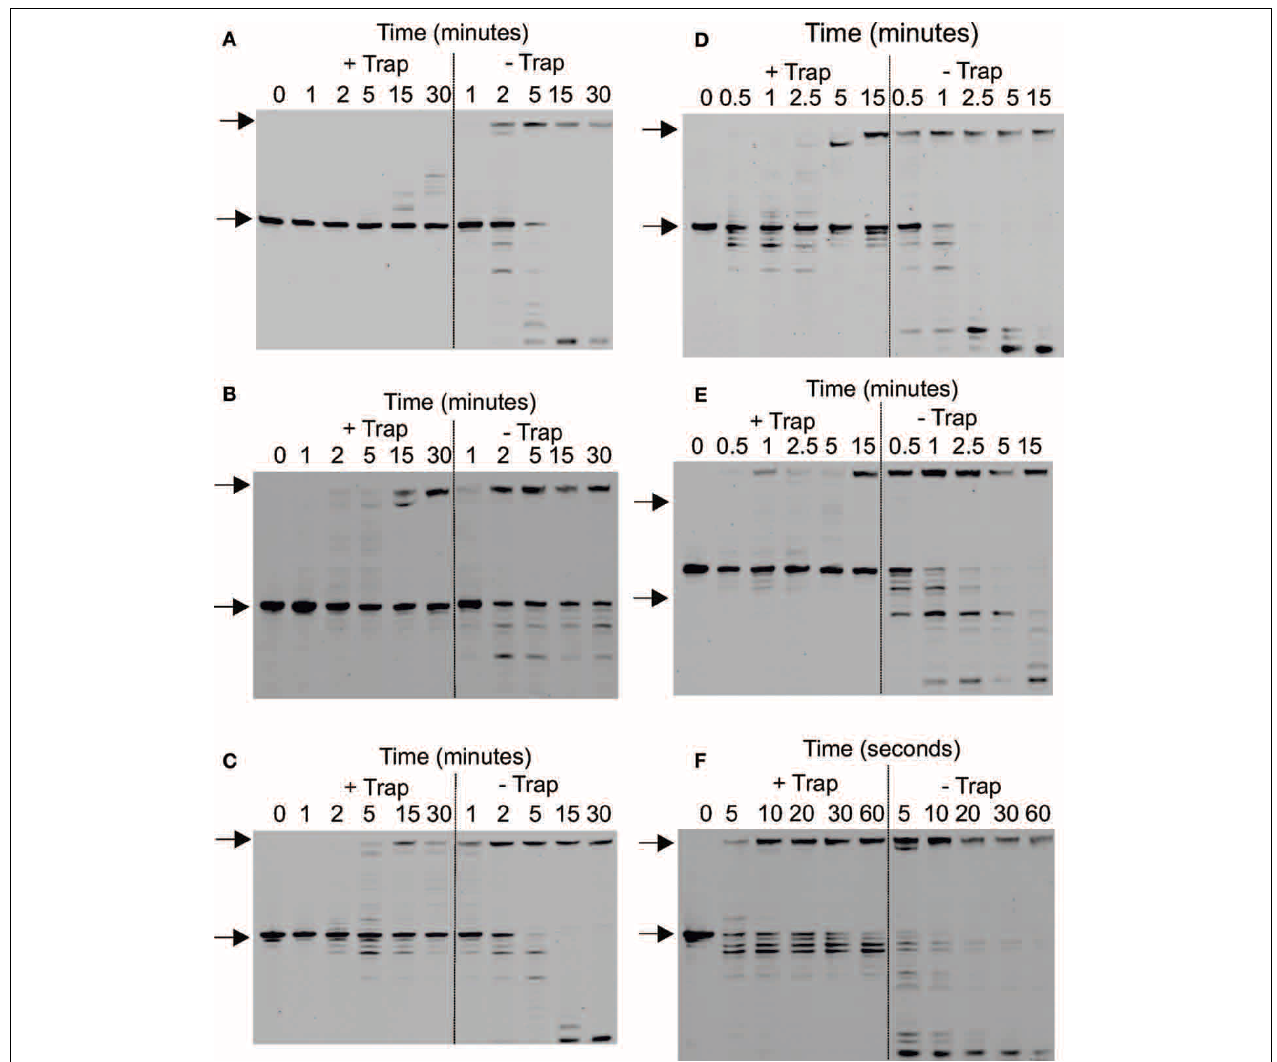
CCGTTCGTTCGAACAGAGTACCTGGCTAT The primer was labeled at the 5 (cid:2) -teminus with fluorescein and the reaction initiated by the simultaneous addition of Mg 2 + and the uracil rich single-stranded trapping oligodeoxynucleotide 5 (cid:2) -GTTGGUACUCTUAGUCTUTAGGT (extensions labeled + trap). For the extensions labeled—trap the competitor was omitted. Larger versions of each of the gel are given in the supplementary section (supplementary data Figure